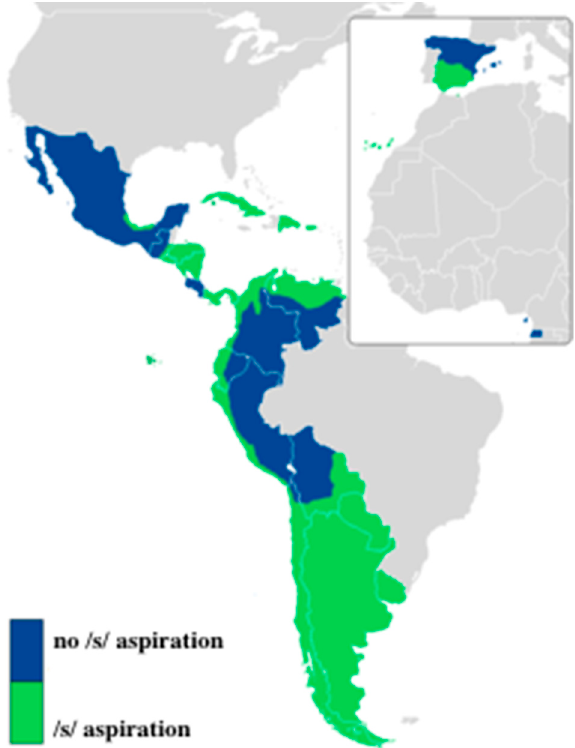
Figure 2. Distribution of coda /s/ aspiration in Spanish. Available online: https://www.reddit.com/r/Spanish/comments/lg8nxb/map_of_s_aspiration_or_reduction_of_spanish/ (accessed on 20 November 2021).